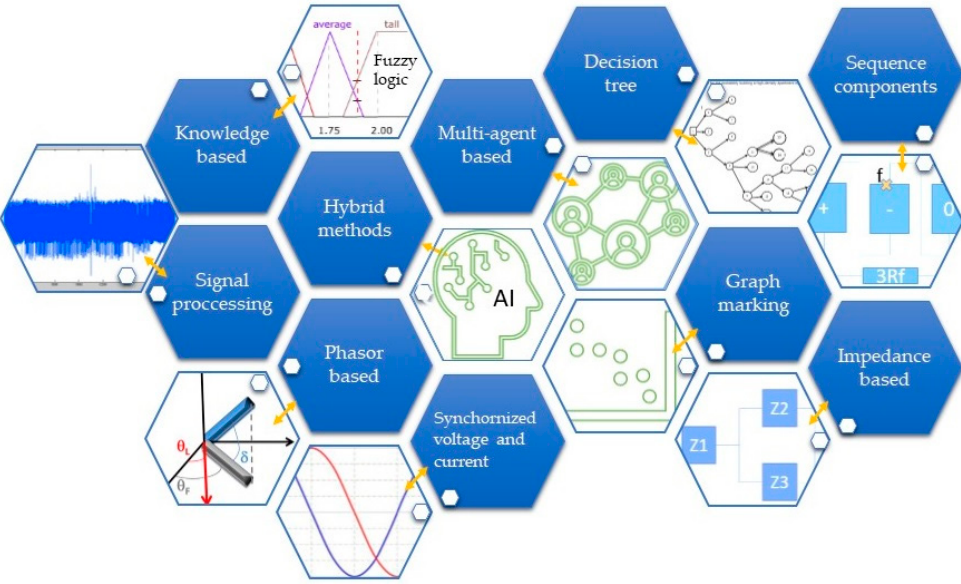
Figure 8. localization techniques in SG [21,45]. Figure 8. Localization techniques in SG [21,45].